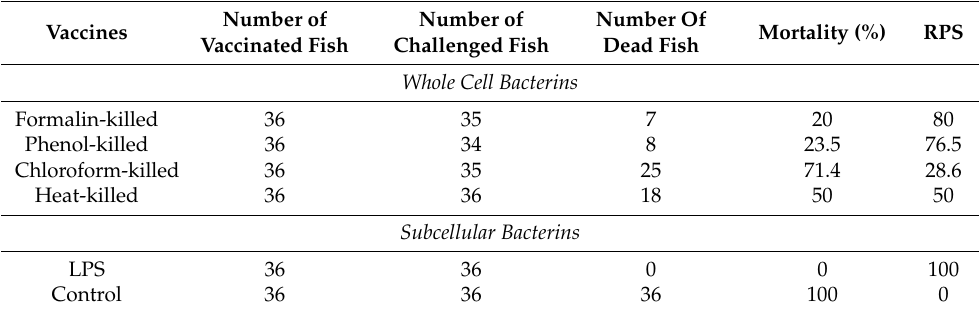
Table 1. Comparative efficacy of different vaccines against Vibrio alginolyticus in silver sea bream, Sparus sarba